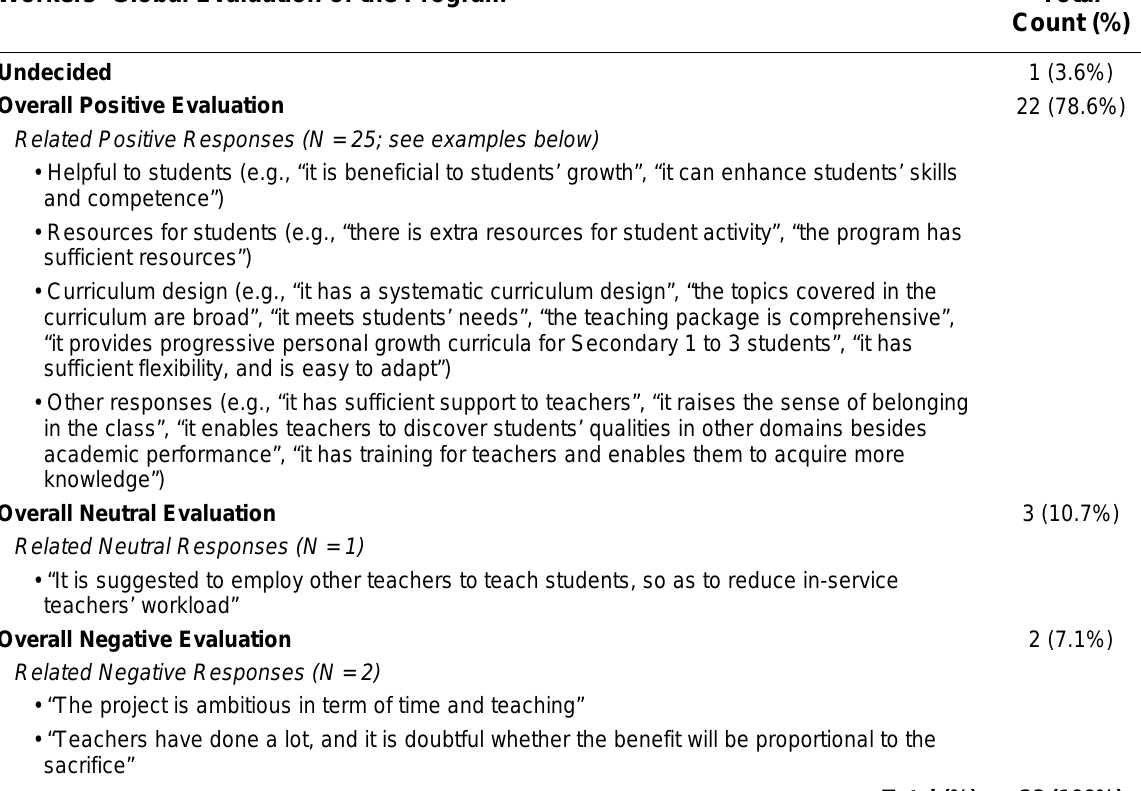
Global Evaluation of the